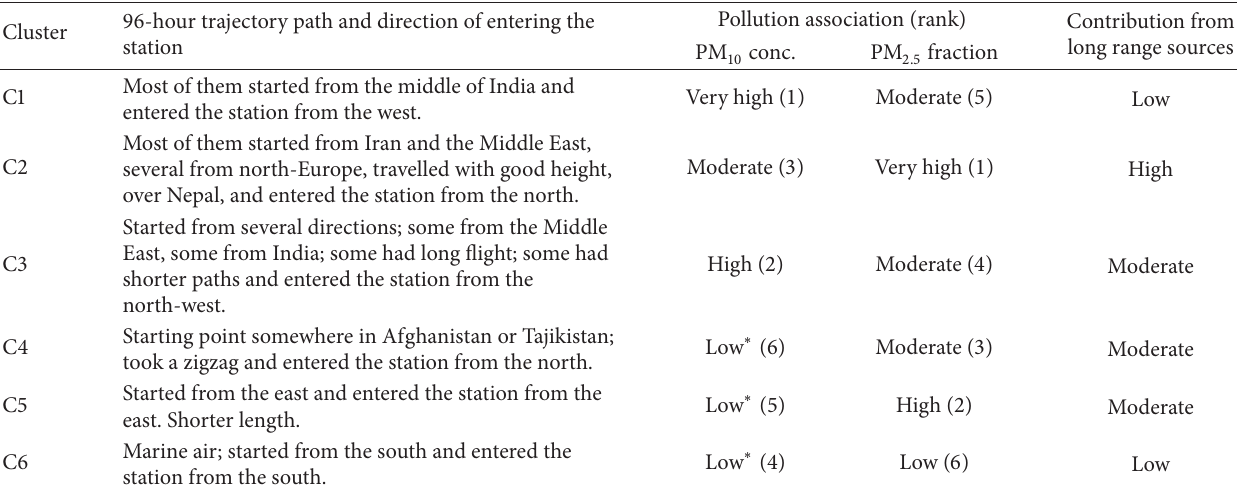
Table 2: Trajectory paths and ranks in their association with high pollution at Gazipur station.